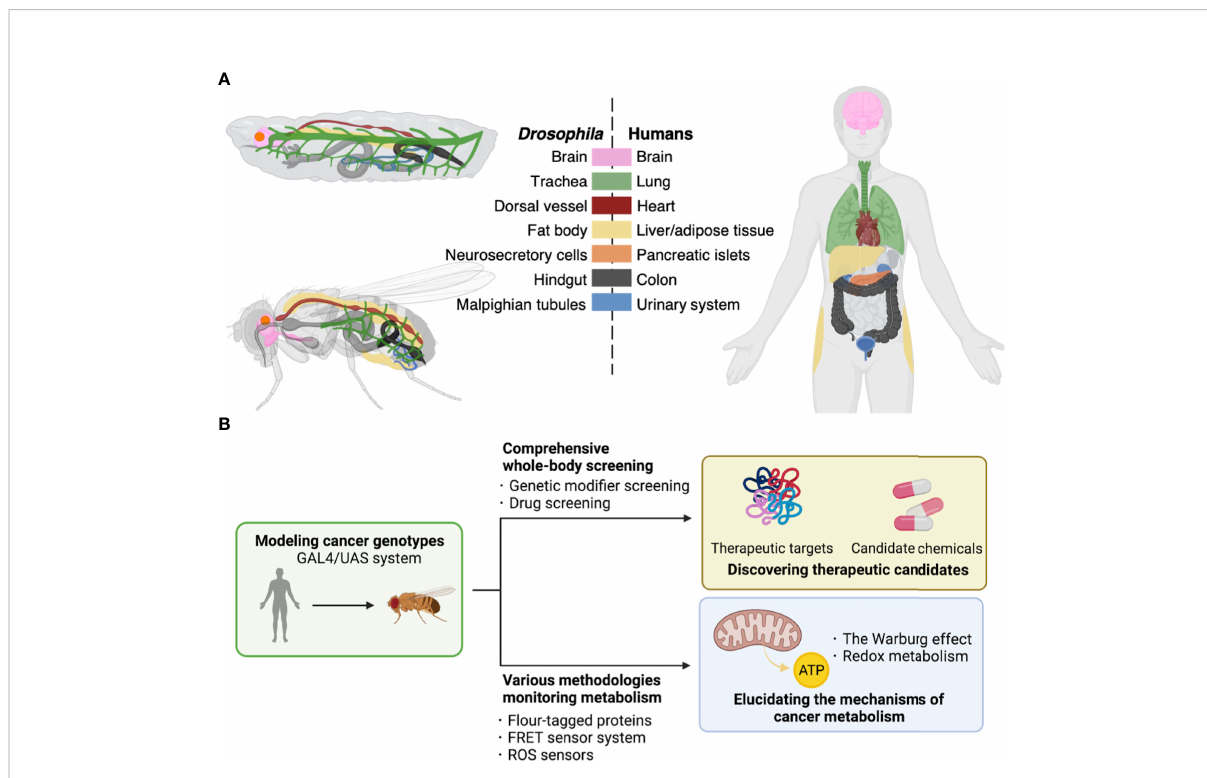
FIGURE 1 Drosophila platforms to study cancer and its metabolism. (A) , Corresponding tissues/organs regarding their structures and functions between Drosophila and humans. Each color indicates tissues/organs with similar functions among Drosophila larva (top upper left) and adult (bottom left), and human (right). Such similarities among metabolic pathways and physiological responses allow construction of fl y models for human diseases of both cancers and metabolic disorders. (B) , The GAL4/UAS system enables induction of genes of interest in target fl y tissues. These fl ies have allowed discovery of therapeutic targets including kinases and development of potent compounds for cancer treatment by comprehensive screenings (top). Furthermore, fl ies offer a useful toolkit including reporter lines to study cancer metabolism